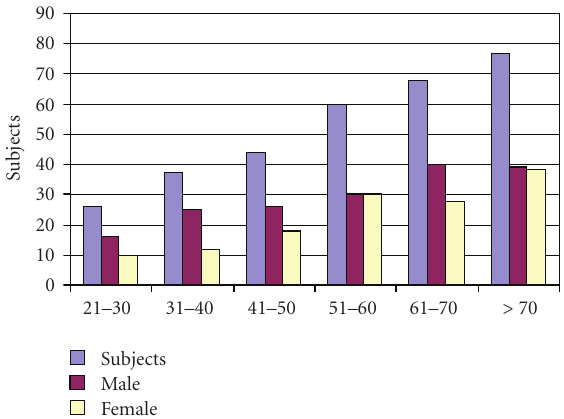
Figure 1: Distribution of the decades of age and sex ( χ 2 = 5 . 15, df = 5, P = .